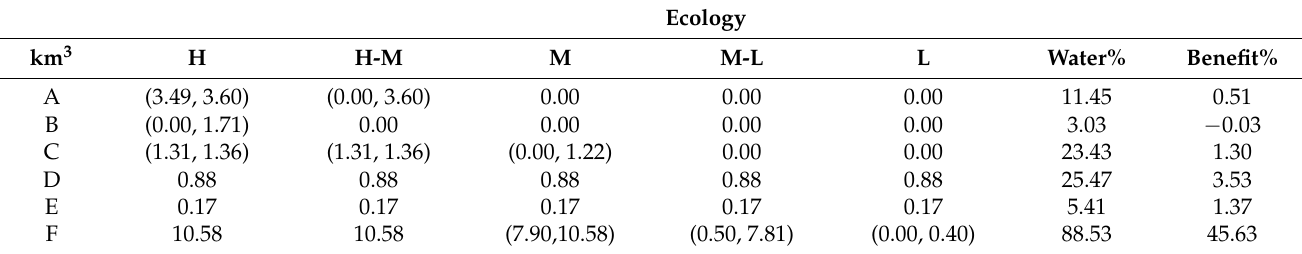
Table 14. Water allocation scheme in the sector of